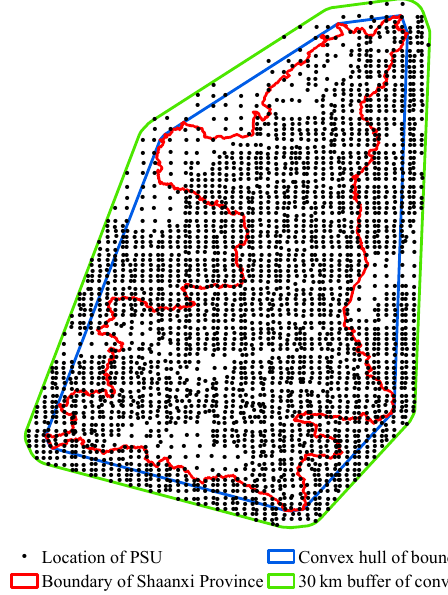
Figure 4. Distribution of PSUs used in this study.